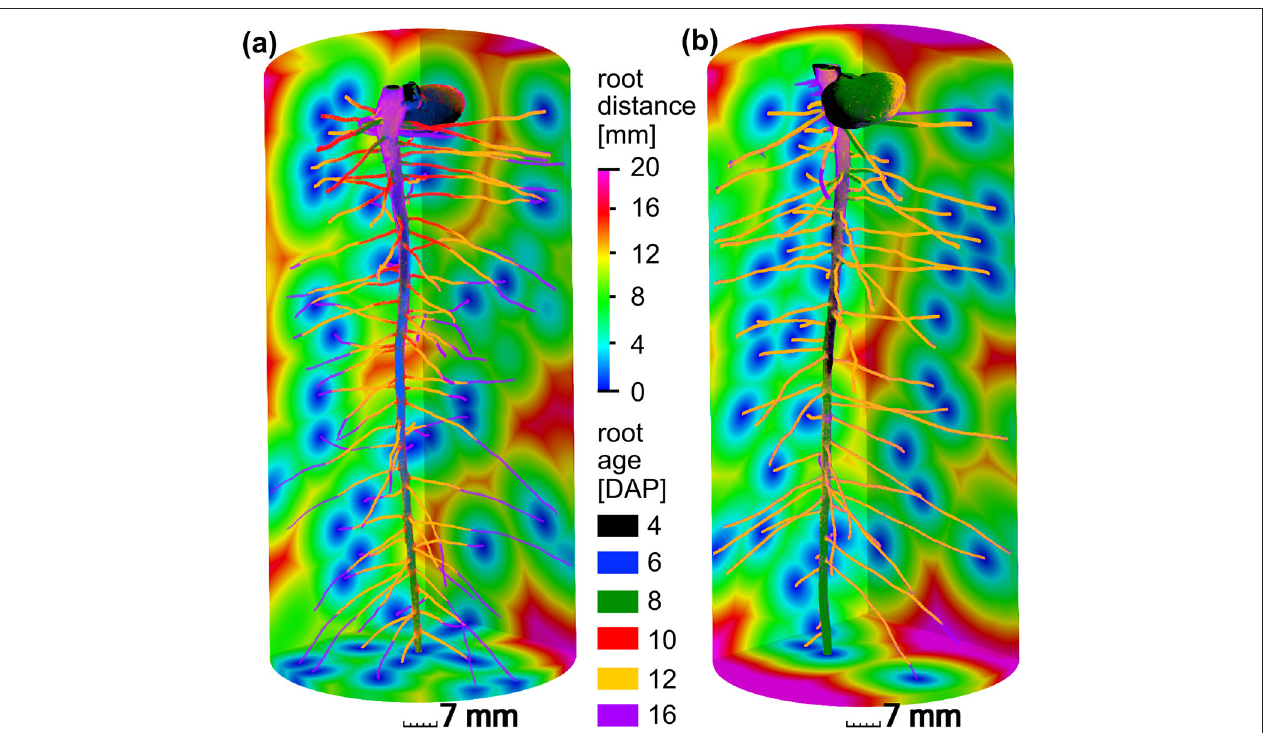
FIGURE 2 | Different root growth dynamics of Vicia faba in two radiation treatments: (a) frequent scanning (FS) every second day exposed to an estimated total dose of 7.8Gy, (b) moderate scanning (MS) every fourth day exposed to an estimated total dose of 4.2Gy. Accordingly, time step (6 DAP, blue) and (10 DAP, red) are only available for frequent scanning (a) . The main difference between both treatments is the slower growth of laterals around 12 days after planting (DAP) in the FS treatment. The root distances in the soil are depicted for the final time step at 16 DAP.